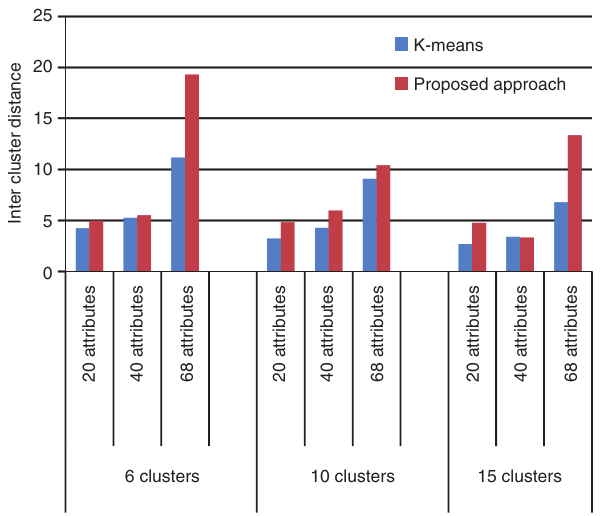
Figure 3: Comparison of Obtained Results for Uscensus Dataset Based on Inter-cluster